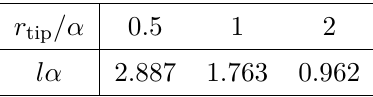
Table 1 . The length l of the entangling interval (in units of the thermal wavelength α − 1 , where α = 2 πT ) as given by the undeformed geodesic (4.7) for cutoff radius r m /α = 10 3 and various values of r tip